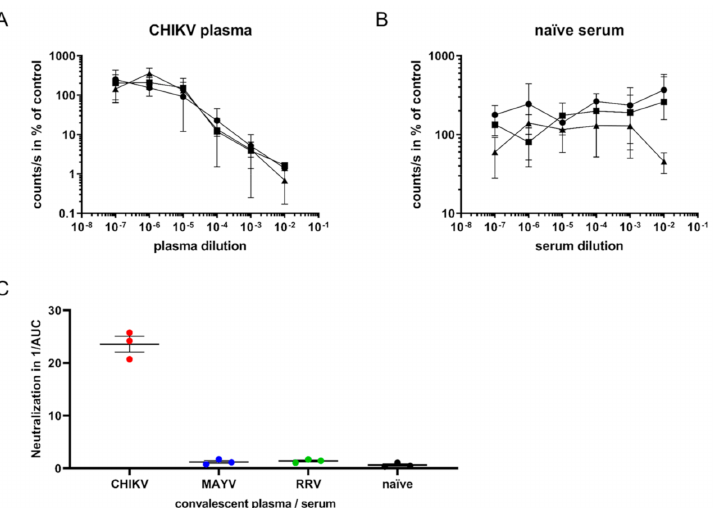
Figure 4. SgP-regulated luciferase expression to determine CHIKV-neutralizing antibodies. ( A ): CHIKV infection of TR-RNA-luc-transfected HEK 293T cells in the presence of three human plasma samples from convalescent CHIKV-infected patients at a dilution ranging from 10 − 2 to 10 − 7 . Infection was determined as luciferase activity in counts/s and is presented as % of untreated control on a log scale. The values represent mean values ± SD of triplicate measurements. ( B ): CHIKV infection in the presence of human naïve serum. ( C ): Area under the curve (AUC) values were calculated using the GraphPad Prism 7.04 software. The reciprocal AUC values of neutralization assays with plasma from CHIKV- or RRV-infected patients and MAYV-infected mouse sera, or naïve serum samples, are depicted to illustrate CHIKV-specific neutralization